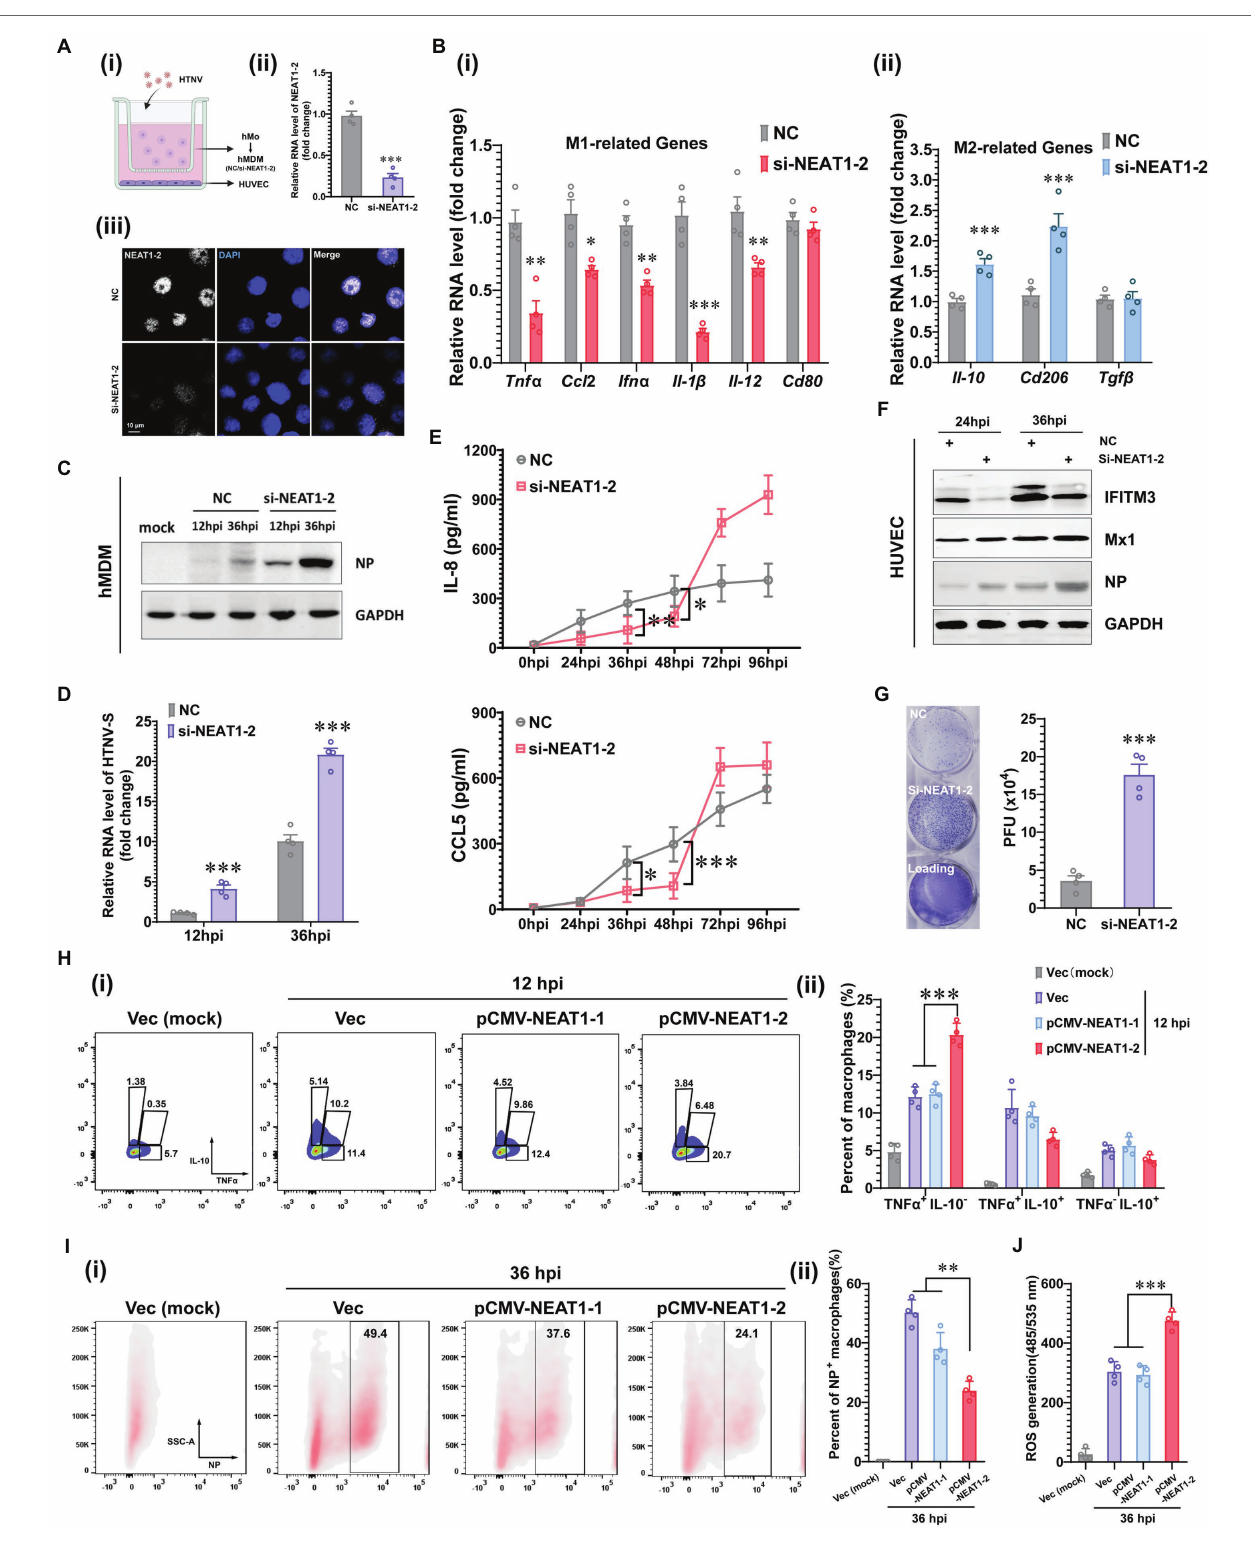
FIGURE 2 | Enhanced M1 Polarization by NEAT1-2 to Constrain HTNV Propagation. (A) (i) Schematic diagram of the coculture system. (ii) RNAi efficiency of NEAT1-2 silencing in hMDMs confirmed by qRT-PCR. (iii) RNAi efficiency of NEAT1-2 in hMDMs confirmed by RNAScope. NC, negative control with scrambled RNAs. (B) (i) qRT-PCR analysis of M1-related genes in hMDMs from the coculture system shown in 2A-(i) . (ii) qRT-PCR analysis of M2-related genes in hMDMs from